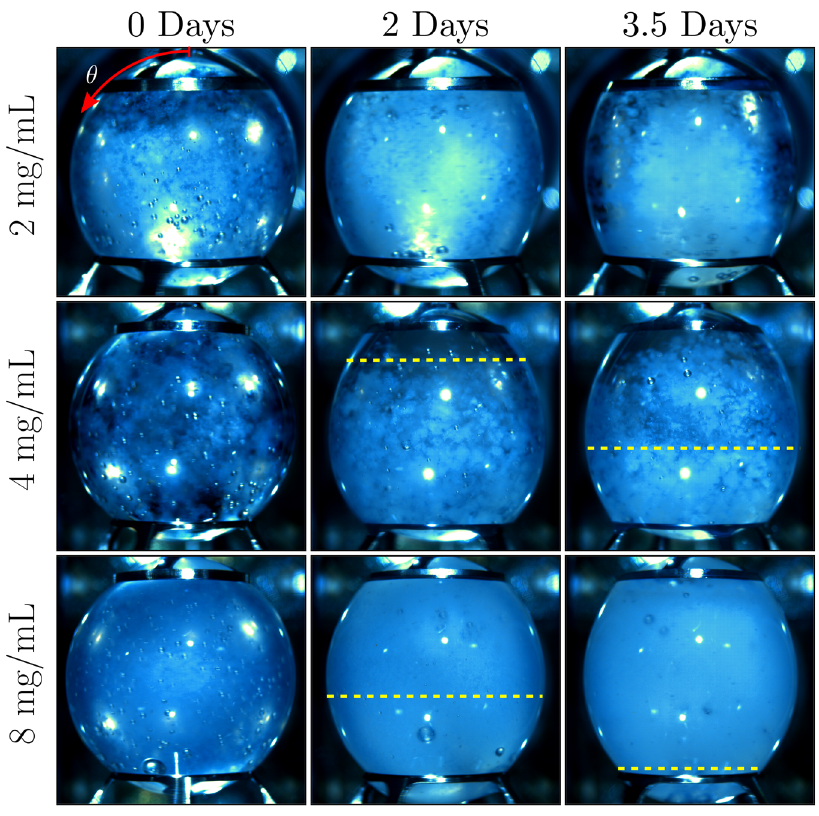
Fig. 6 Images of gelation front progression in pre-sheared insulin cases. If present, southward-moving gelation fronts are indicated by yellow dashed lines.